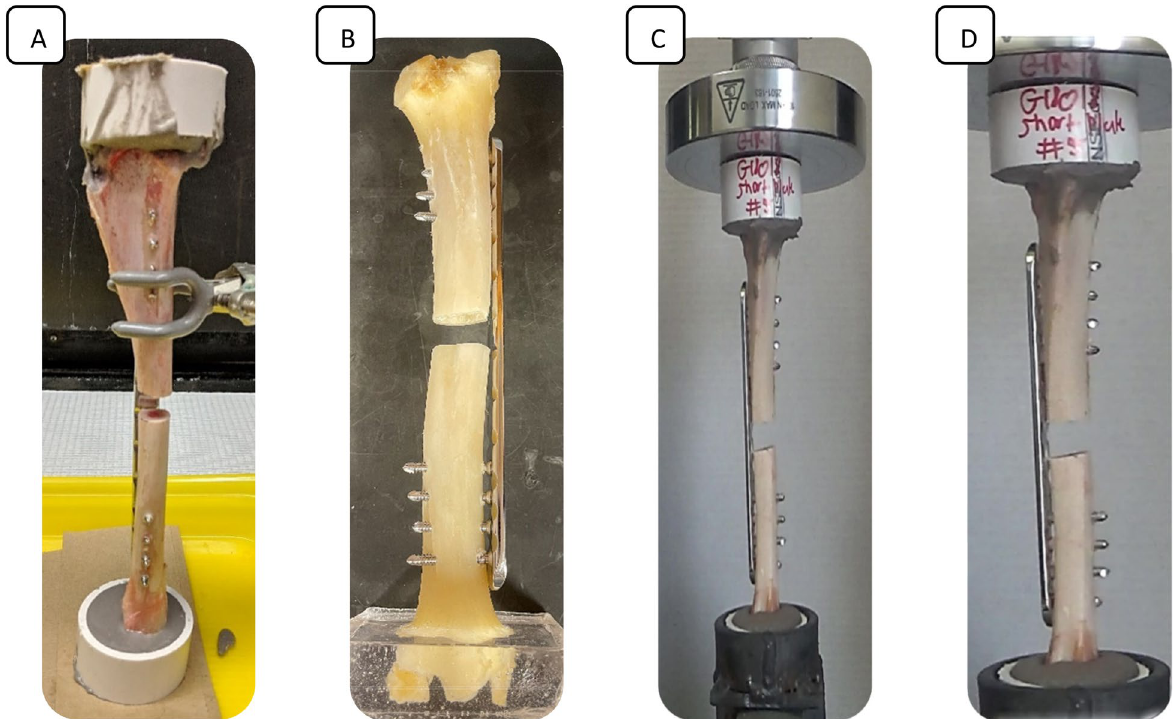
Fig. 1 A Lateral view of tibia specimen mounted in poly‑methyl‑methacrylate prior to mechanical testing. B Caudal view of tibia specimen utilized for model illustration. C and D Cranial and lateral views of tibia specimens mounted in mechanical testing system prior to compression testing. In all specimens, the 1 cm segmental ostectomy is stabilized using an 18 cm ( A and B ) or 14 cm ( C and D ) 316 stainless steel low contact round double threaded 8‑hole, 4.5‑mm thick locking plate applied in a bridging fashion with four bicortical locking screws proximal to the defect and four